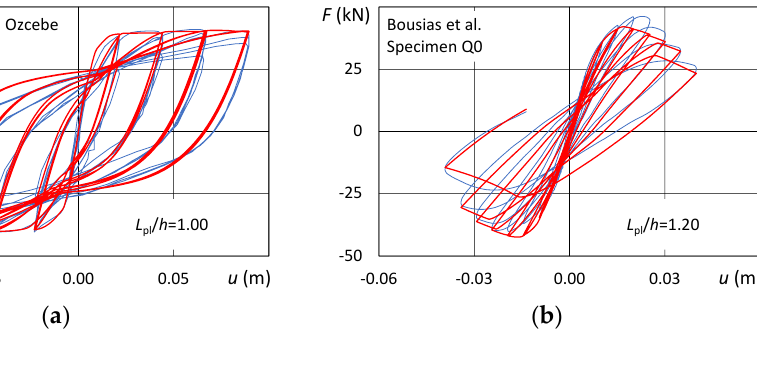
( h ) Figure 7. Comparison between laboratory tests and numerical analyses for the specimen tested by (a) Saatcioglu and Ozcebe [36], (b) Bousias et al. [35], (c) Lukkunaprasit and Sittipunt [41], (d) Saatcioglu and Grira [37], (e) Kanda et al. [39], (f) Ohno and Nishioka [40], (g) Bousias et al. [34] and (h) Saatcioglu and Grira [37]; Notes: (blue line) laboratory test; (red line) numerical analysis. 9. Proposed Expression of the Length of the Plastic Hinge To propose a relation for the determination of the length of the plastic hinge, the values of L pl obtained through calibration have been plotted as a function of the main ge- ometric and mechanical parameters of the specimens. First, the dependence of L pl on the normalized axial force ν has been investigated. Among the selected tests, the values of ν (0.0 ÷ 0.77) vary in a wide range of values and this should be sufficient to identify any